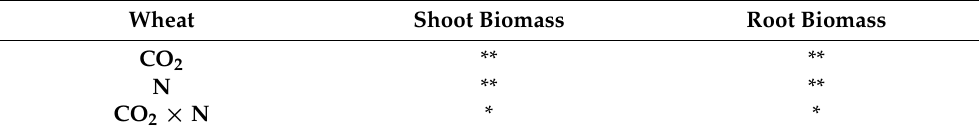
Table 4. Two-factor ANOVA analyses for wheat biomass. Wheat Shoot Biomass Root Biomass CO 2 ** ** N ** ** CO 2 × N * *